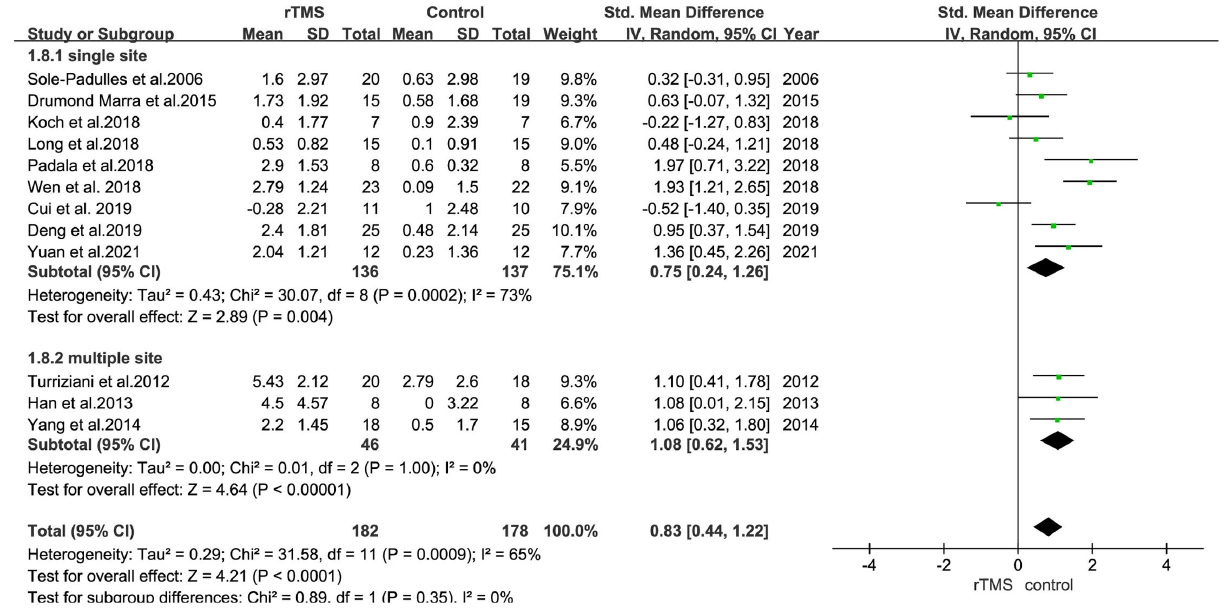
Analysis of rTMS stimulation parameters showed that